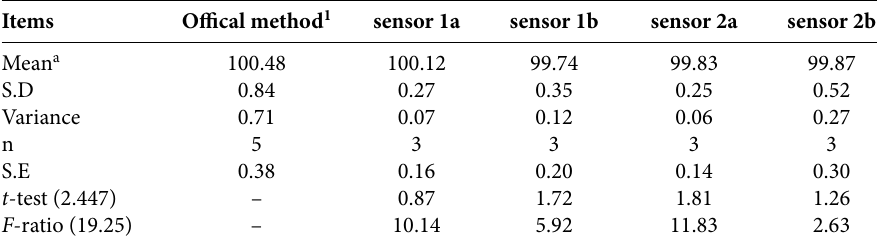
Table 3. Determination of Lab in Labipress plus ® tablets by the proposed sensors Preparation Company method b Labipress Plus tablets Found a Assay Assay Assay Assay Each tablet contains ± RD Found a ± RD Found a ± RD Found a ± RD Found a ± RD 100 mg labetalol HCl, 25 mg hydrochlorothiazide B.N.: 141019